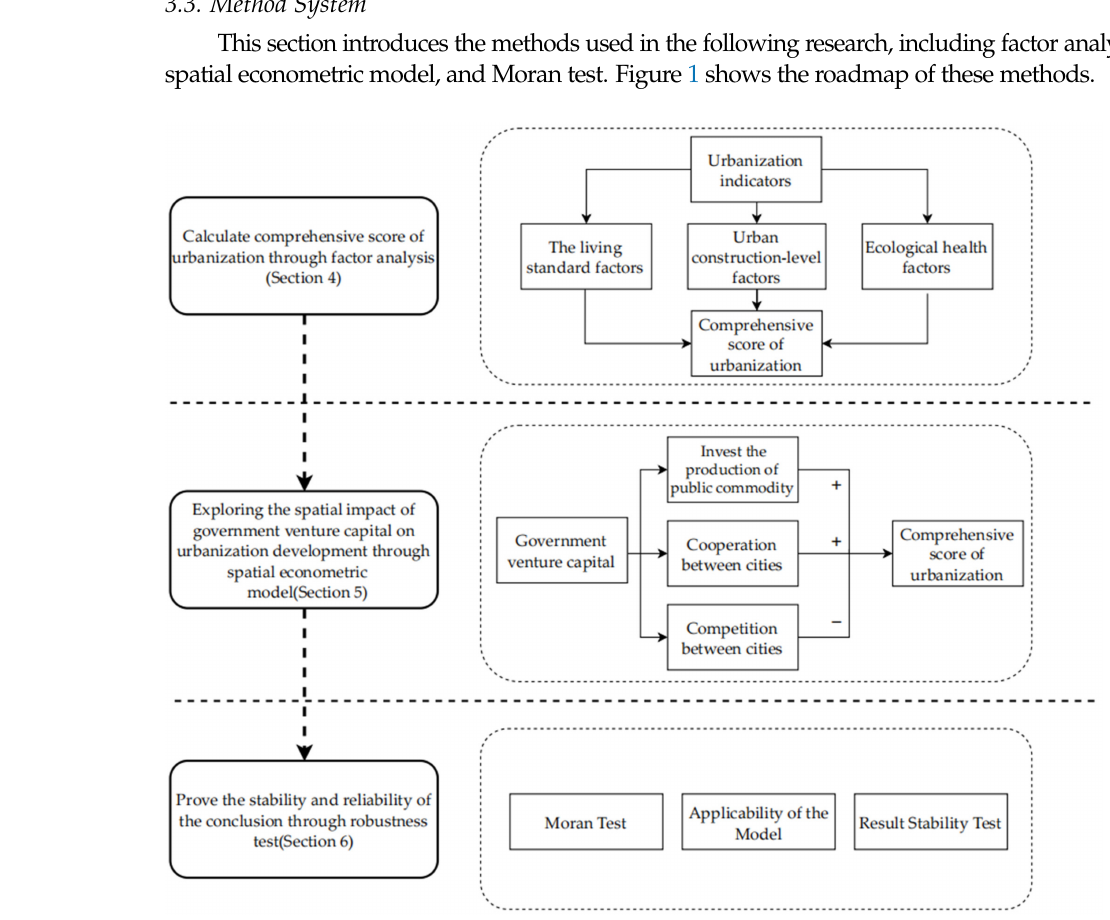
Figure 1. Roadmap of